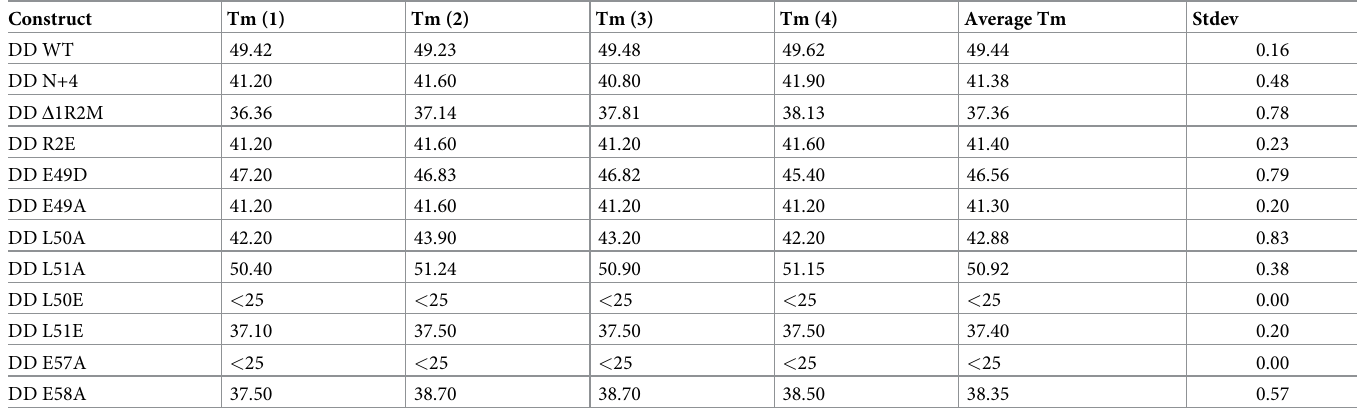
Table 2. Tm values of PRC1-DD and its mutants.